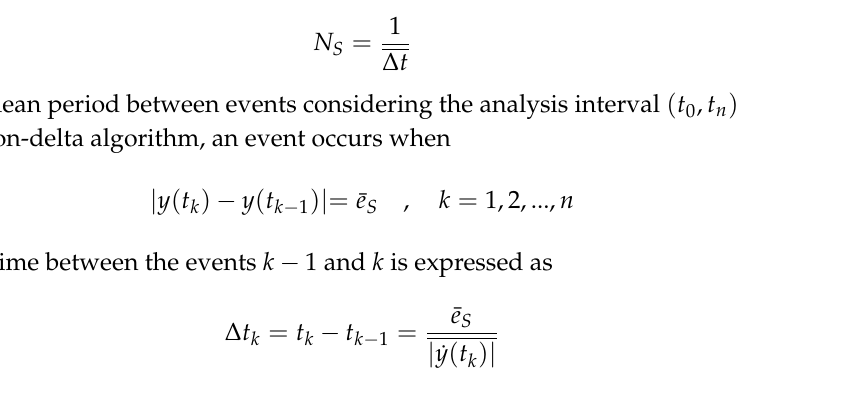
Figure 2. Sampling strategies: ( a ) periodic sampling; ( b ) send-on-delta; and ( c ) integral